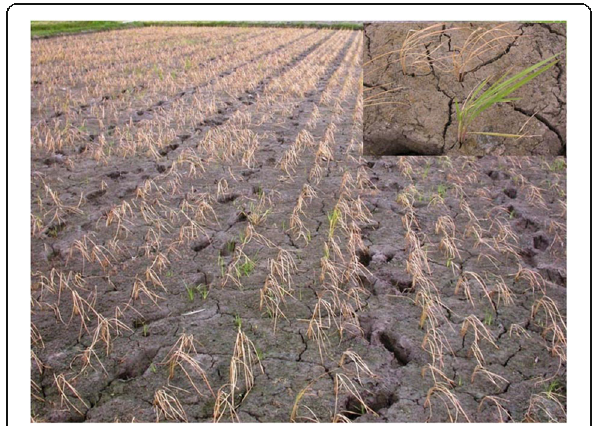
Fig. 1 Overall view of imazethapyr treated field and identification of resistant plant (inset) in M 2 generation